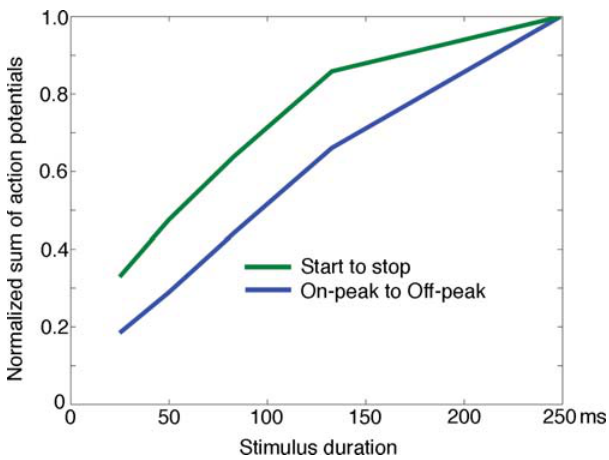
Figure 7. Predicting the stimulus duration from the spike trains. For all spike trains having significant firing (p , 0.01) the number of spikes were summed from the first significant bin to the last significant bin (irrespective if the firing between the ON and OFF responses was significant) for each condition. The maximal sum for each animal was set to 1.0 and the other sums normalized accordingly. This gave the green curve: start-stop. The blue curve was calculated similarly, but such that the sum of spikes was only taken between the peak of the ON response and the OFF response: peak-to-peak.